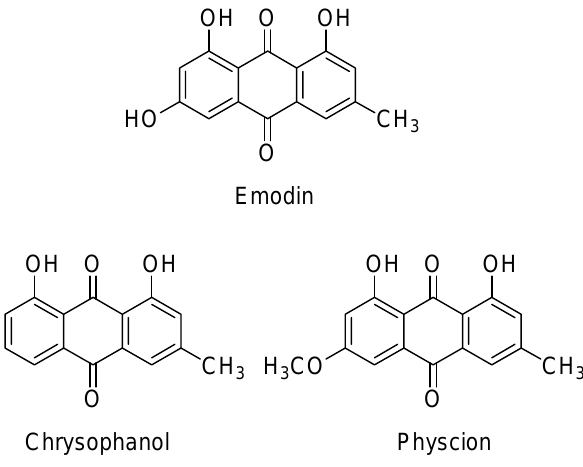
Figure 1. Chemical structures of the target compounds from R. japonicas